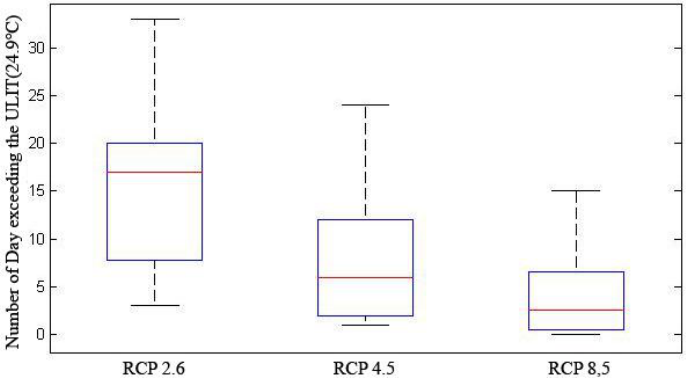
Figure 10. Boxplot of number of the day over UILT of the brook trout for each RCP climate scenarios; RCP 2.6, RCP 4.5 and 8.5. RCP 2.6, RCP 4.5 and